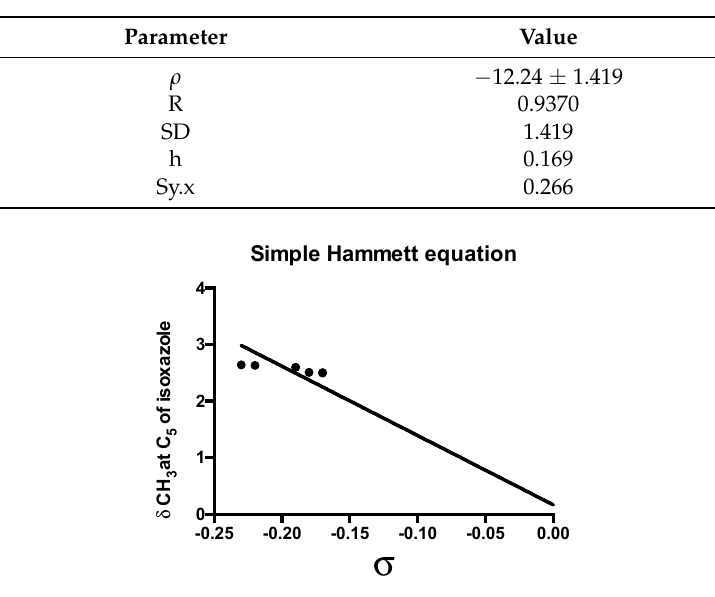
Figure 5. Hammett equation fit of the chemical shift of CH 3 at C 5 of isoxazole of compounds 7 – 12 .